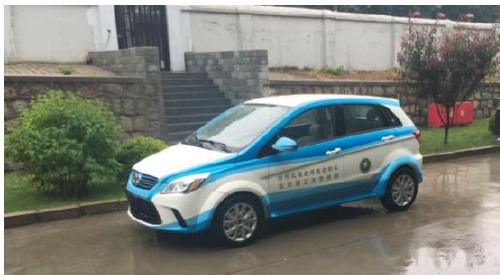
Figure 7. The experimental prototype. Table 1. The main parameters of the prototype.